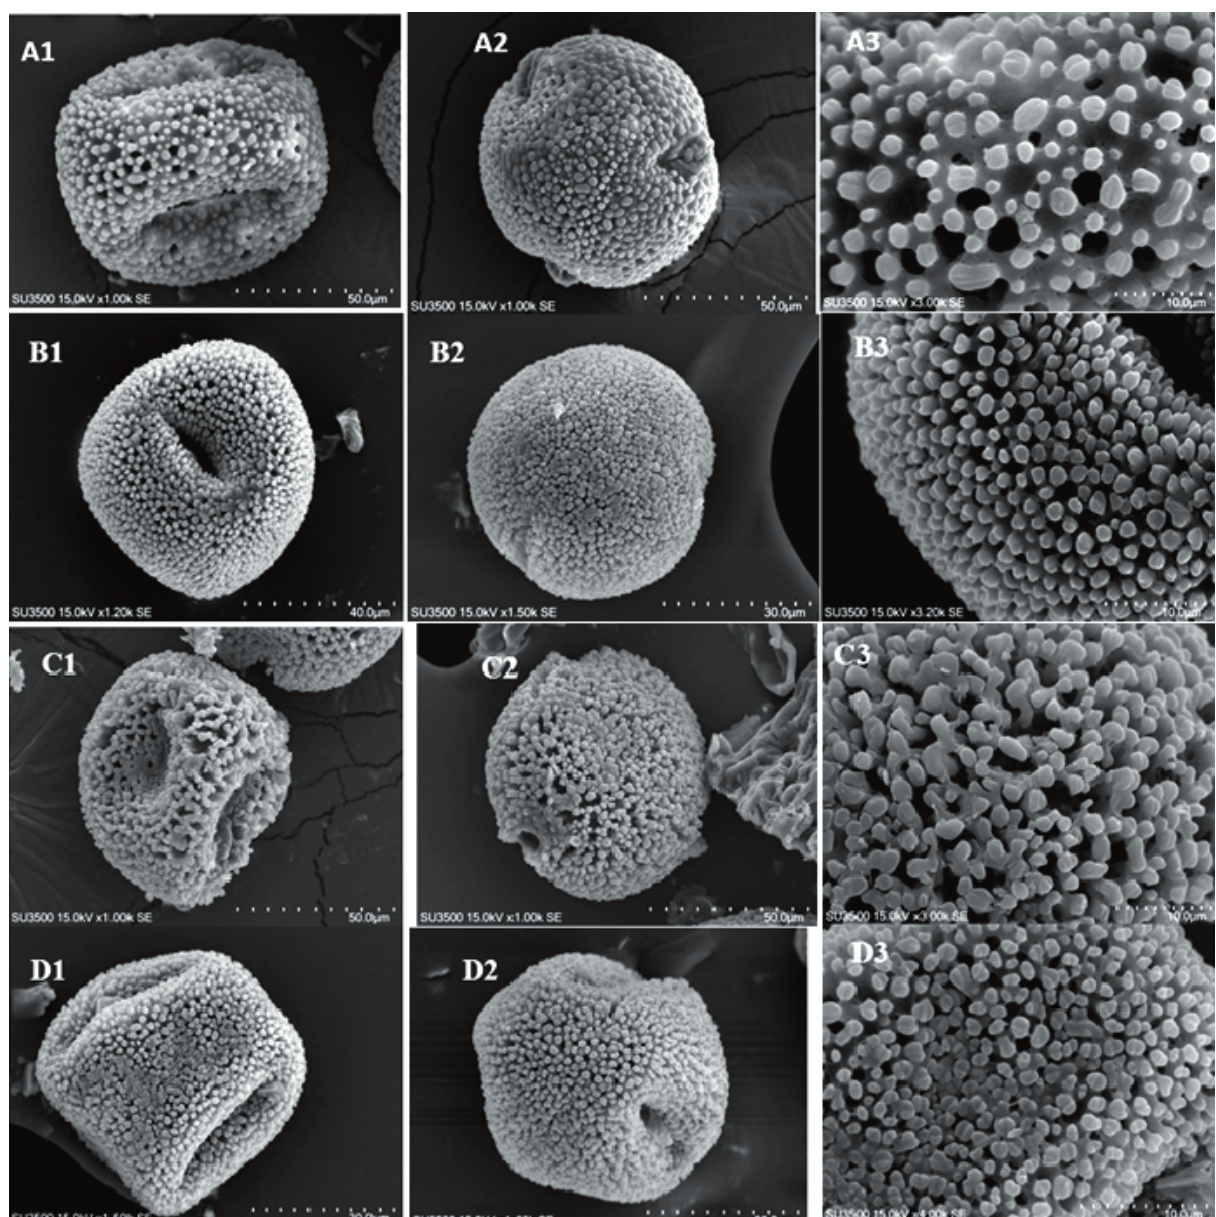
Figure 2. Pollen micrographs of Geranium species: A1-A3: G. collinum , B1-B3: G. columbinum , C1-C3: G. pratense , D1-D3: G. dissectum; A1, B1,C1, D1 – equatorial view; A2, B2, C2, D2 - polar view; A3, B3, C3, D3 -exine